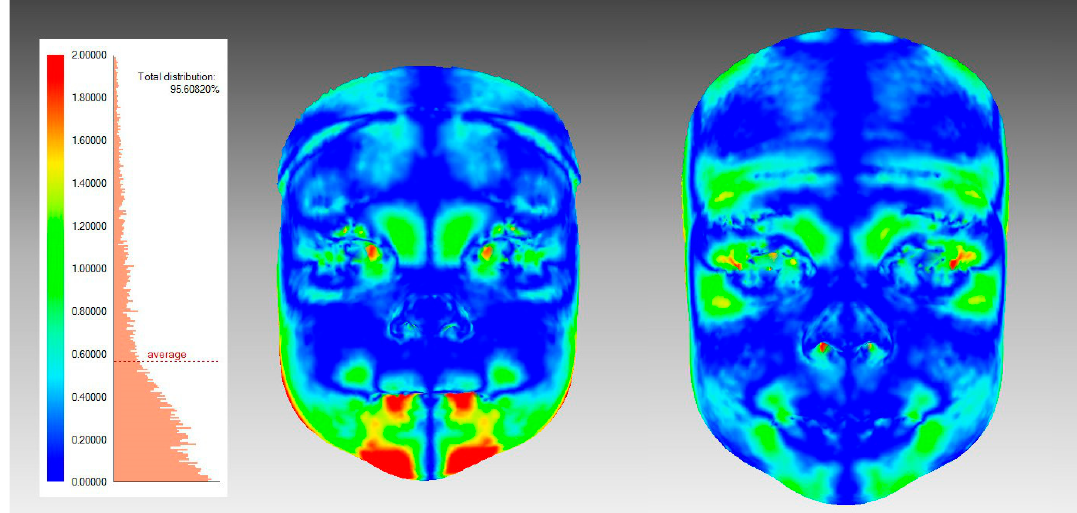
Figure 3. An illustration of surface-based facial symmetry analysis. A color-map is showing one participant’s facial asymmetry at T1 (left figure) and T2 (right figure); The colors demonstrate the deviations between the original and the mirrored facial